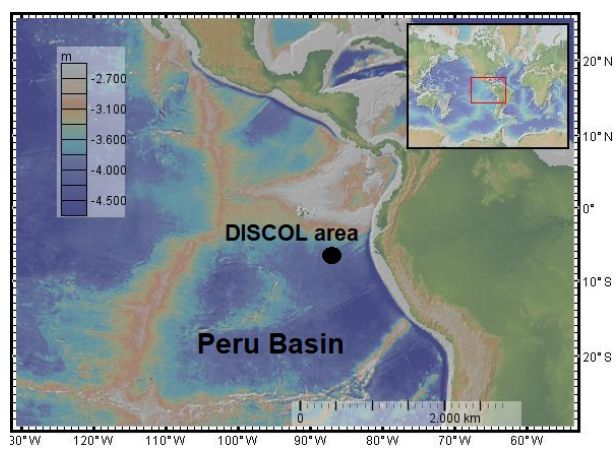
Figure 1. The Peru Basin, with the location of the DISCOL area. The map was created using GeoMapApp (http://www.geomapapp. org, last access: 18 December 2019) and its integrated default basemap Global Multi-Resolutional Topography (GMRT) (Ryan et al.,